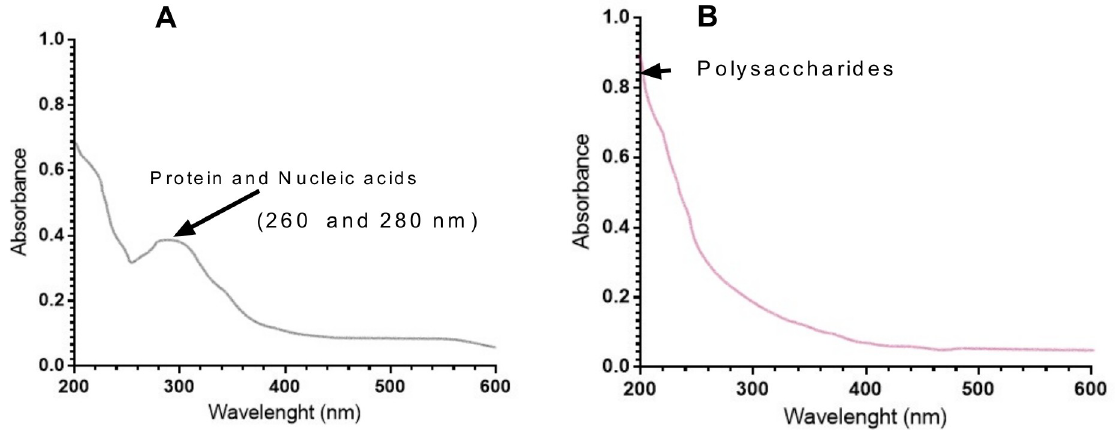
Fig 4. UV-spectrophotometric analysis of partially purified polysaccharides (POP). A) Before proteolysis and B) after removing of protein and nucleic acids. The peaks in the range of 950–1200 cm -1 indicate the presence of polysaccharides, indicating the presence of glycosidic bonds by 1,150–1,160 cm -1 .